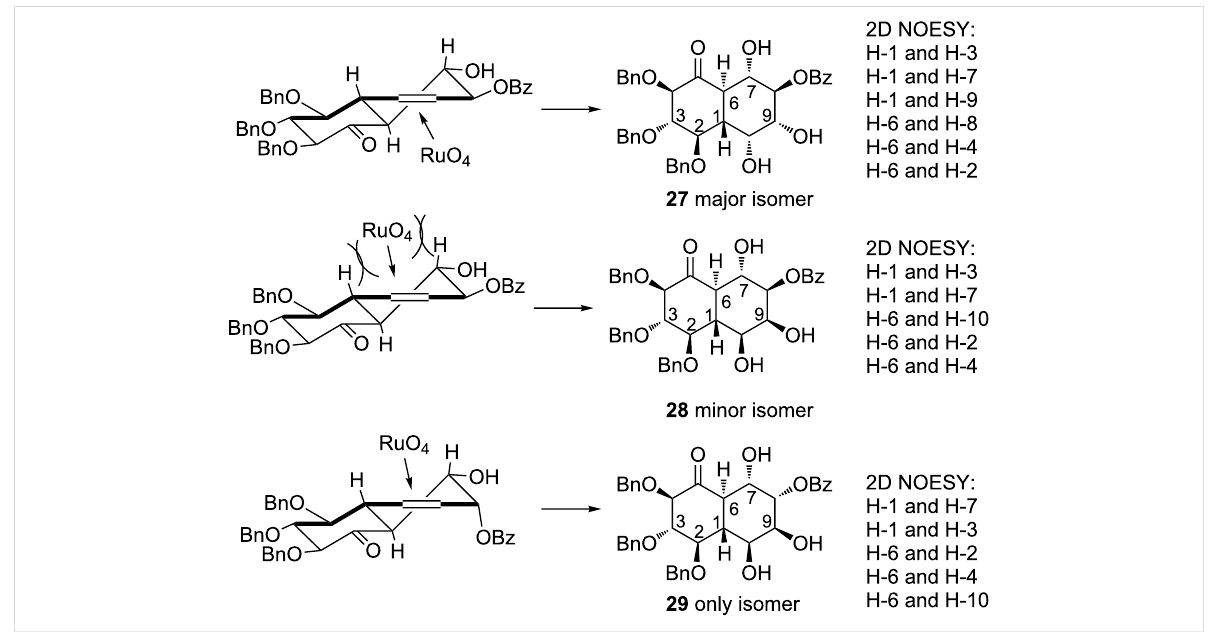
Figure 2: Possible course of the syn -dihydroxylation leading to 27 , 28 , and 29 .